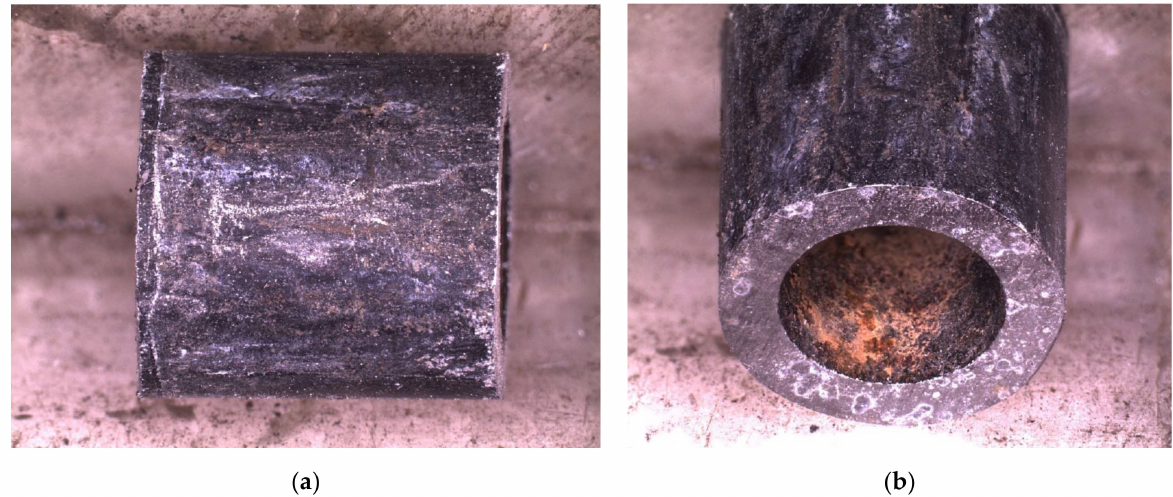
Figure 5. Photographs of a fabricated O-ring specimen viewed from ( a ) the side and ( b ) the end. Remains of what is most likely hematite is visible on the inner surface. The inside of flux thimble tubes are exposed to the air outside the reactor, while the outside is exposed to the reactor water